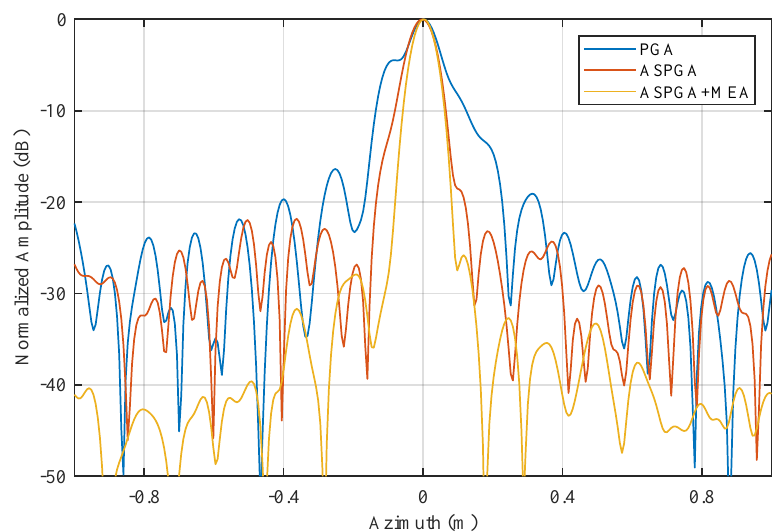
Figure 8. Azimuth responses of strong scatterer at the right bottom